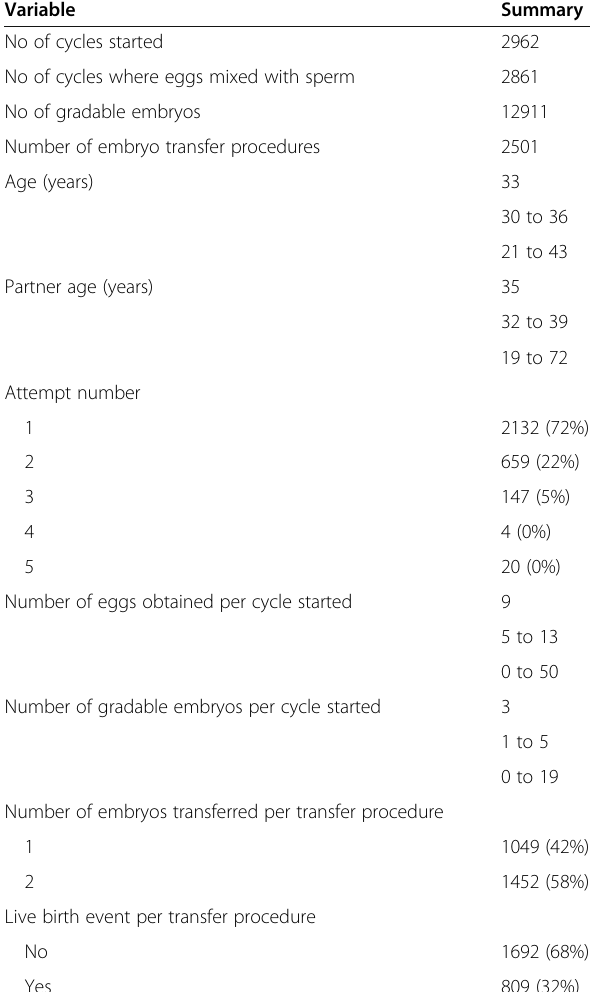
“ Application of the methods to routinely collected IVF data ” section. Median, interquartile range and range for